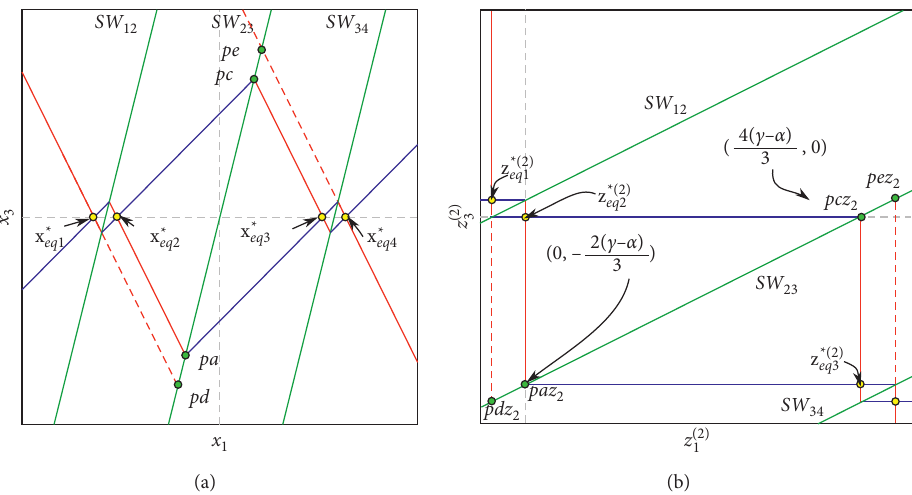
− x ) plane and (b) ( z ( 2 ) − z ( 2 ) ) plane. The stable and unstable manifolds are marked with 1 3 1 3